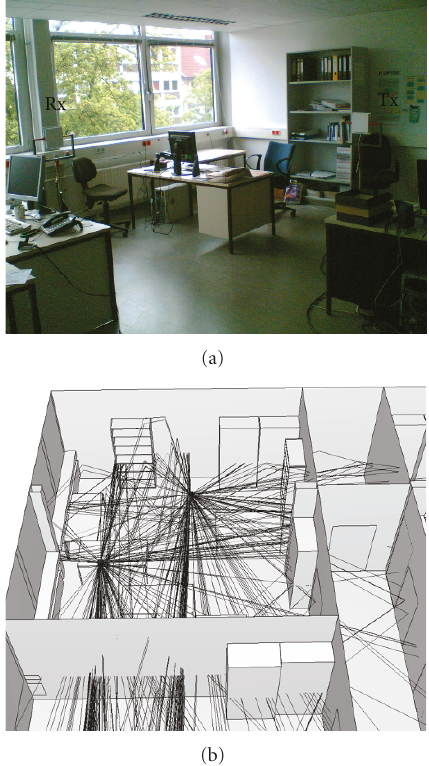
Figure 1: (a) A measurement configuration within an o ffi ce room with (b) a 3D ray